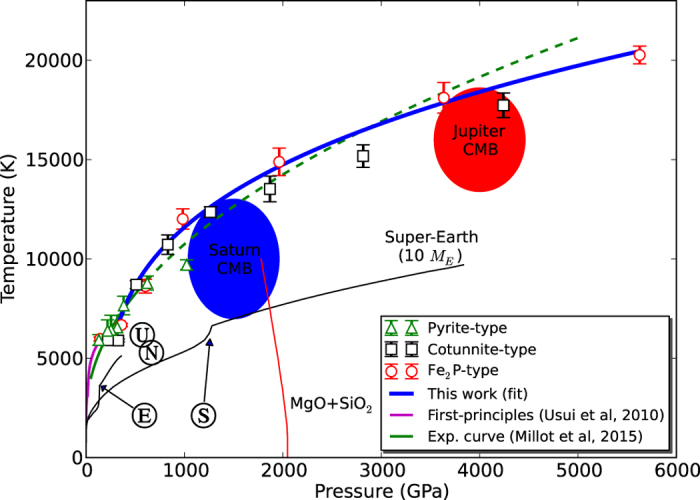
Melting data of SiO2, along with P-T conditions predicted for the interior of rocky planets of 1 and 10 Earth masses.Green triangles, black squares and red circles represent the melting conditions for pyrite, cotunnite and Fe2P phases, respectively. Error bars indicate the uncertainty in the melting temperature computed by the Bayesian procedure44. The melting curve of silica is obtained by fitting our data (thick, blue line, Equation (1)) using the Simon fit equation up to 6 TPa. The blue and red shaded areas correspond to the core-mantle boundary conditions (CMB) Saturn and Jupiter, respectively133. CMB for Earth (E), a super-Earth (S), Uranus (U)61 and Neptune (N)61 are shown for comparison. The predicted dissociation of MgSiO3 post-perovskite into MgO and SiO2 is shown in red2122. The melting curve of SiO2 at the highest pressures available to date, obtained from two-phase MD simulations24 (magenta) and from experiments up to 500 GPa23 (in green, and dashed when extrapolated), are also shown. The black lines stand for Super-Earth (10 ME) and Earth (1 ME) internal pressure-temperature ranges obtained from planetary models56.